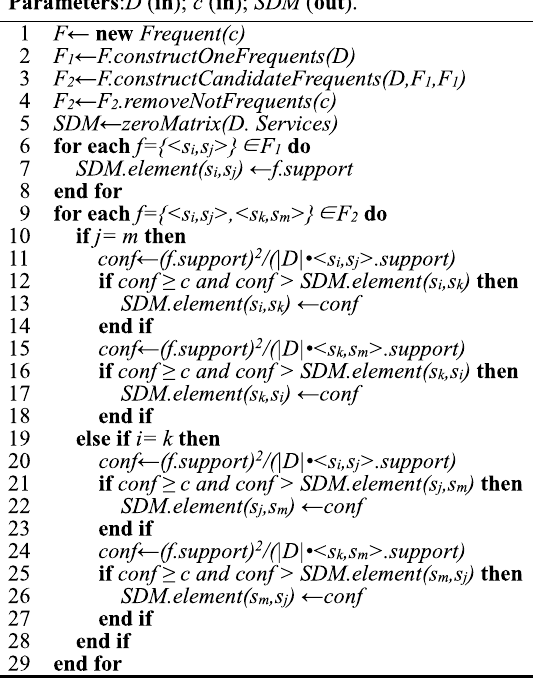
Algorithm 1 Service dependence matrix generation